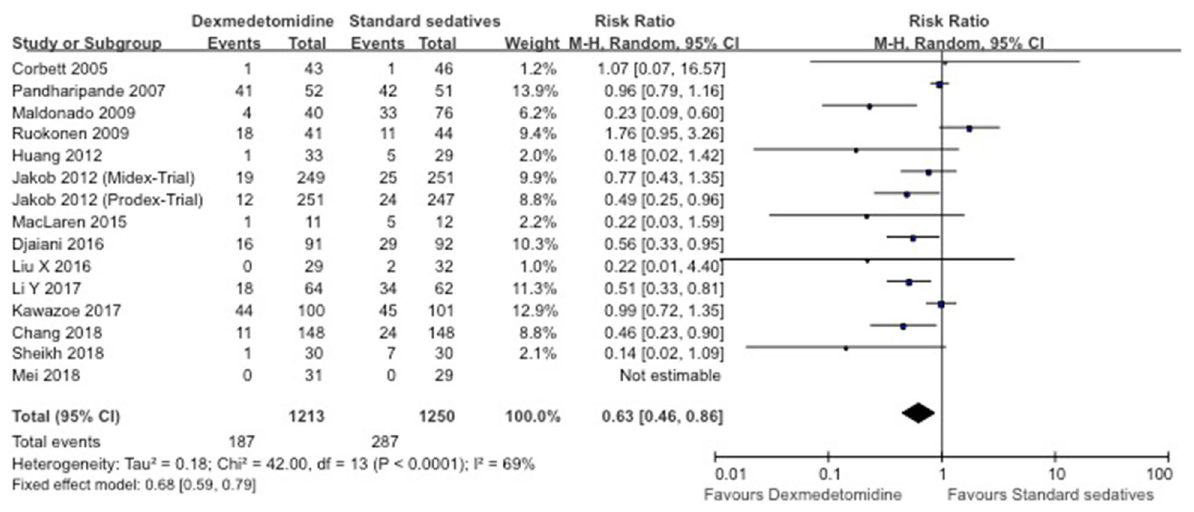
Fig. 3 Forest plot for incidence of delirium in standard sedative-controlled RCTs